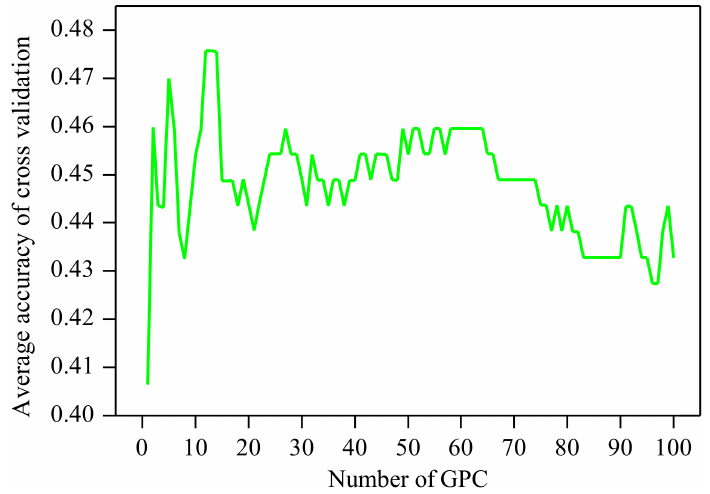
Figure 6. Average accuracy of five-fold cross validation under different numbers of GPC.